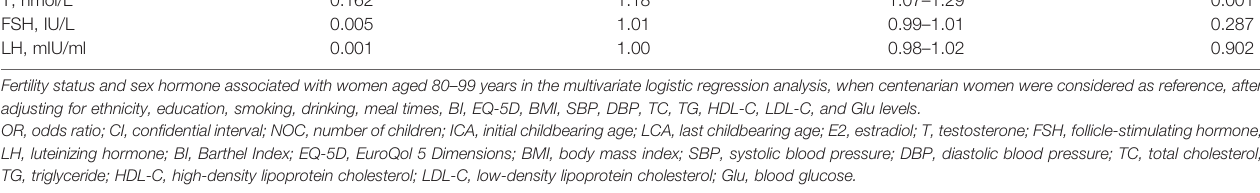
TABLE 2 | Fertility status and sex hormone associated with women aged 80 – 99 years in logistic regression analysis with centenarian women as reference. Variables B OR